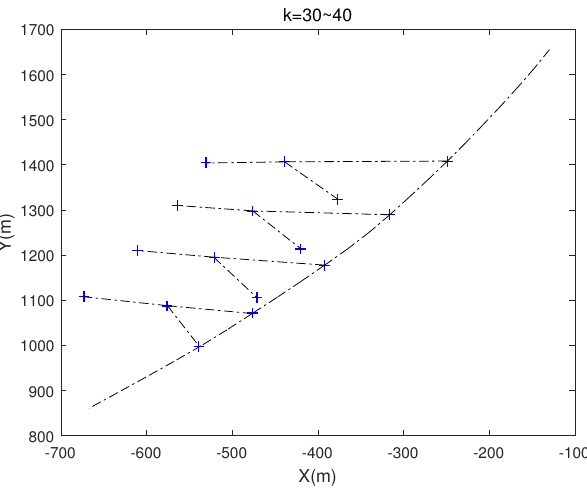
Figure 20. The position of the target at k = 30 to k =